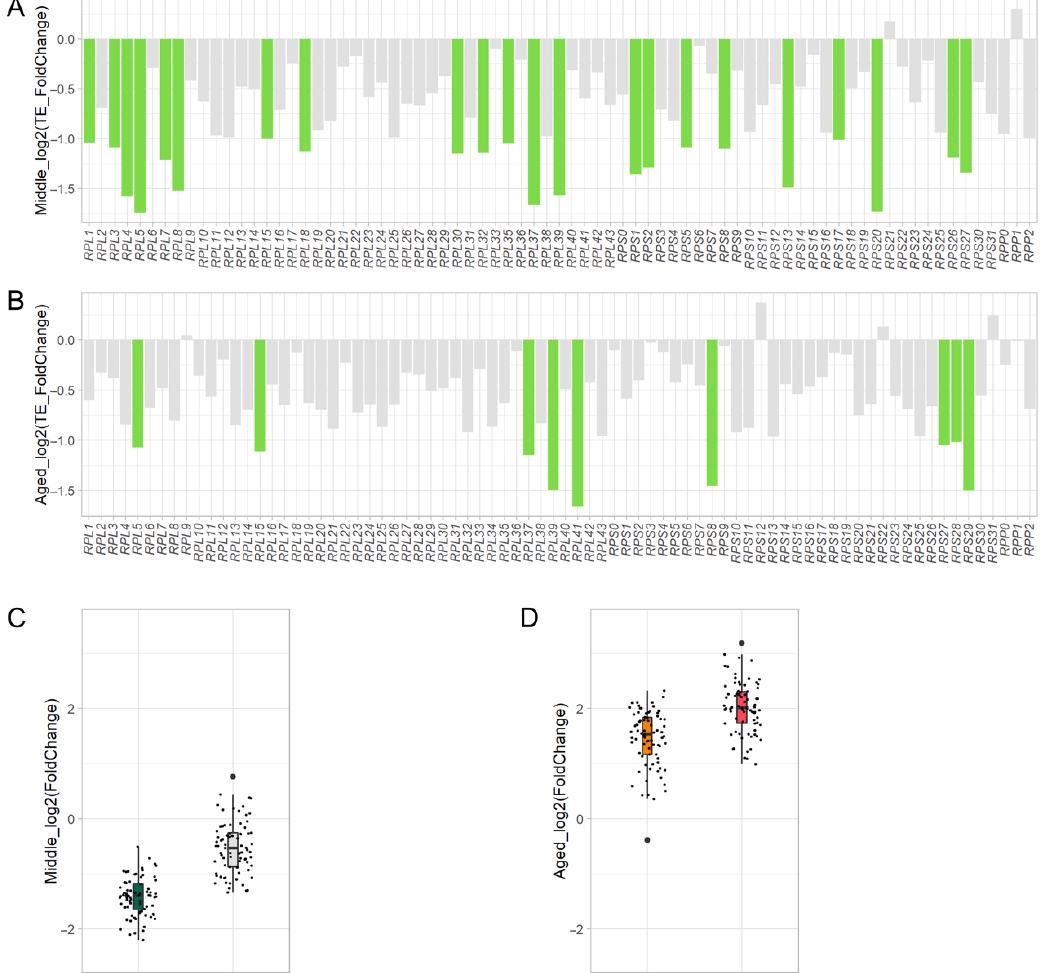
Figure 4. Translation of ribosome components decreases during aging. Changes in translational efficiency (TE) of ribosome proteins in Middle ( A ) and Aged ( B ) cells. Green indicates downregulation by more than twofold. Young yeast cells were used as the control. Changes in Ribo-Seq and transcription in Middle ( C ) and Aged ( D ) cells. Orange and dark green indicate upregulation and downregulation of Ribo-Seq, respectively, by more than twofold. Red indicates upregulation of transcription by more than twofold. The outlier is shown as a large black dot.